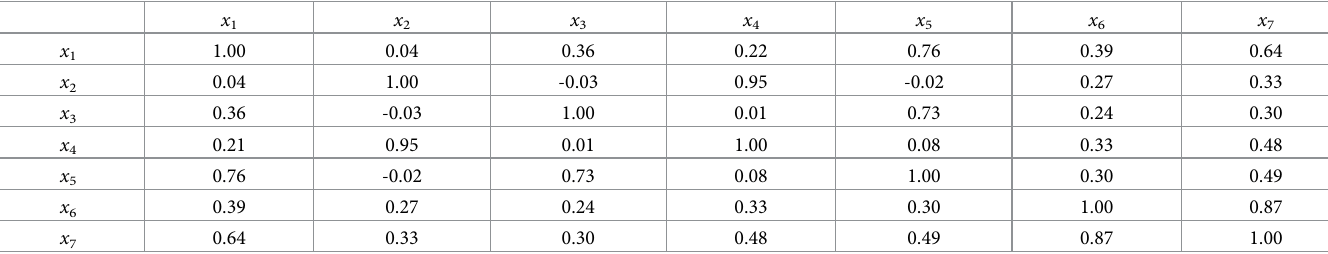
Table 3. Correlation between estimated